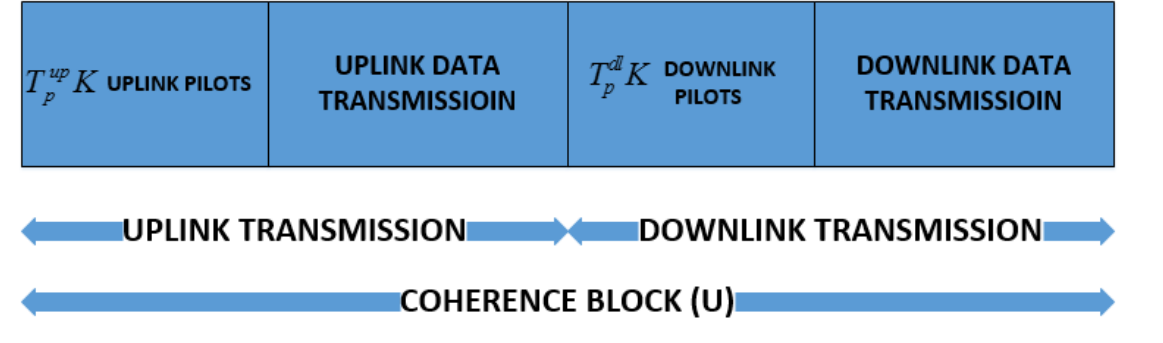
Figure 1. Frame Structure of Massive MIMO.